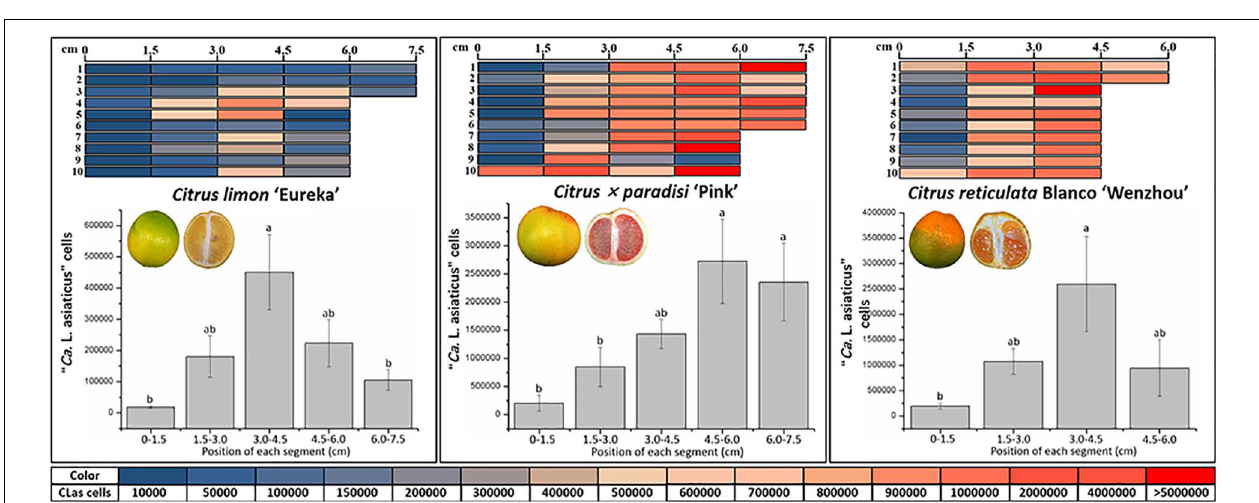
FIGURE 2 | Quantitative distribution of “ Candidatus Liberibacter asiaticus” (CLas) in fruit piths of three citrus varieties. Graphic denoted 1.5-cm segment of fruit piths. Color scale indicates the CLas cell number in each 1.5-cm segment following quantitative real-time PCR. The average number of CLas cells in each 1.5-cm segment of fruit piths from individual citrus variety is indicated as bar graph. The different letters at the top of the bar represent significant difference by single-factor analysis of variance (Duncan multiple-range test) at 95% ( P < 0.05) confidence